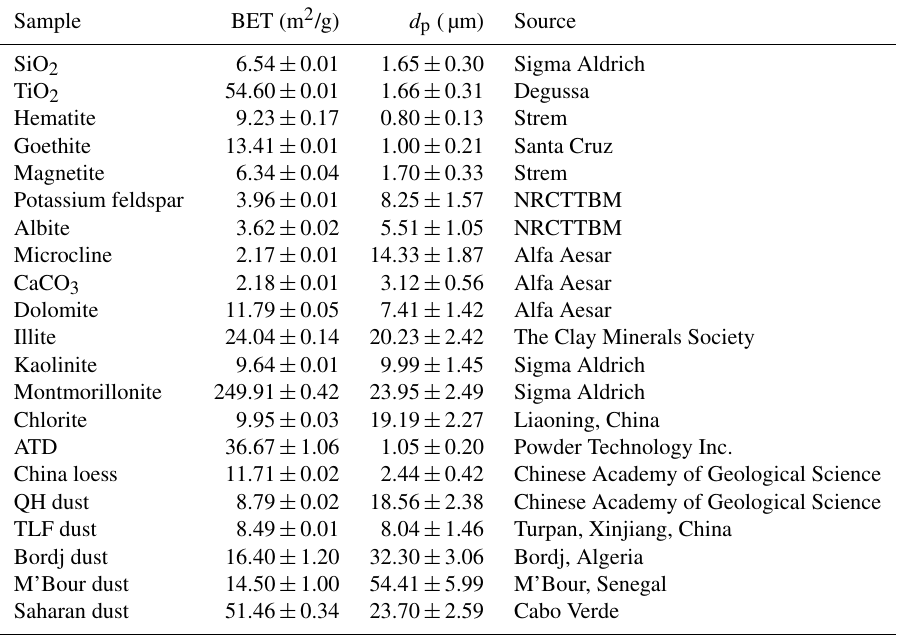
Table 1. Measured BET surface areas (BET), average particle diameters ( d p ) and sources of mineral dust samples examined in this work.